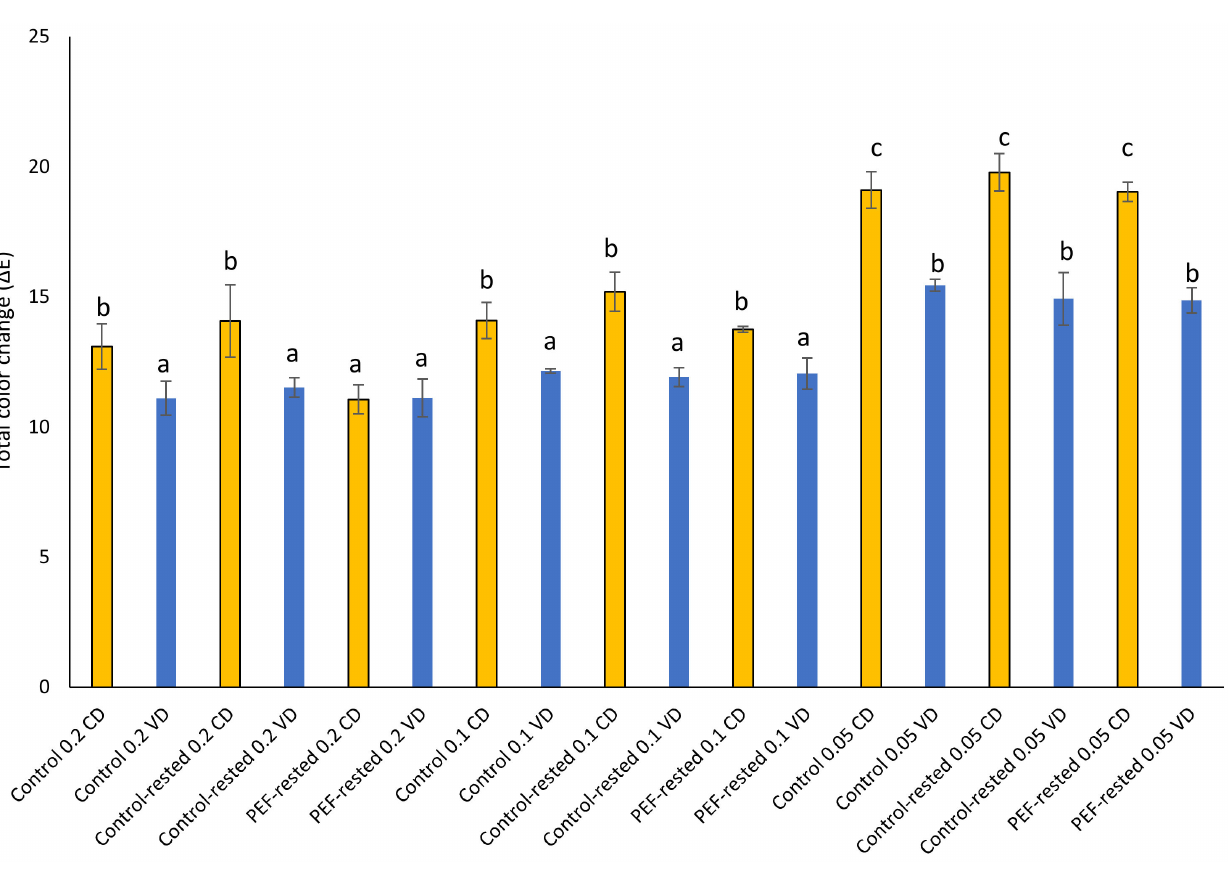
Figure 6. Total color change ( ∆ E) of Thai basil leaf samples subjected to different pretreatments (control, control-rested, and PEF rested) prior drying with convective drying and vacuum dry- ing to the moisture ratio of 0.2, 0.1, and 0.05. Reported are averages and standard deviations of 15 measurements. Different letter superscripts represent statistically significant differences ( p <